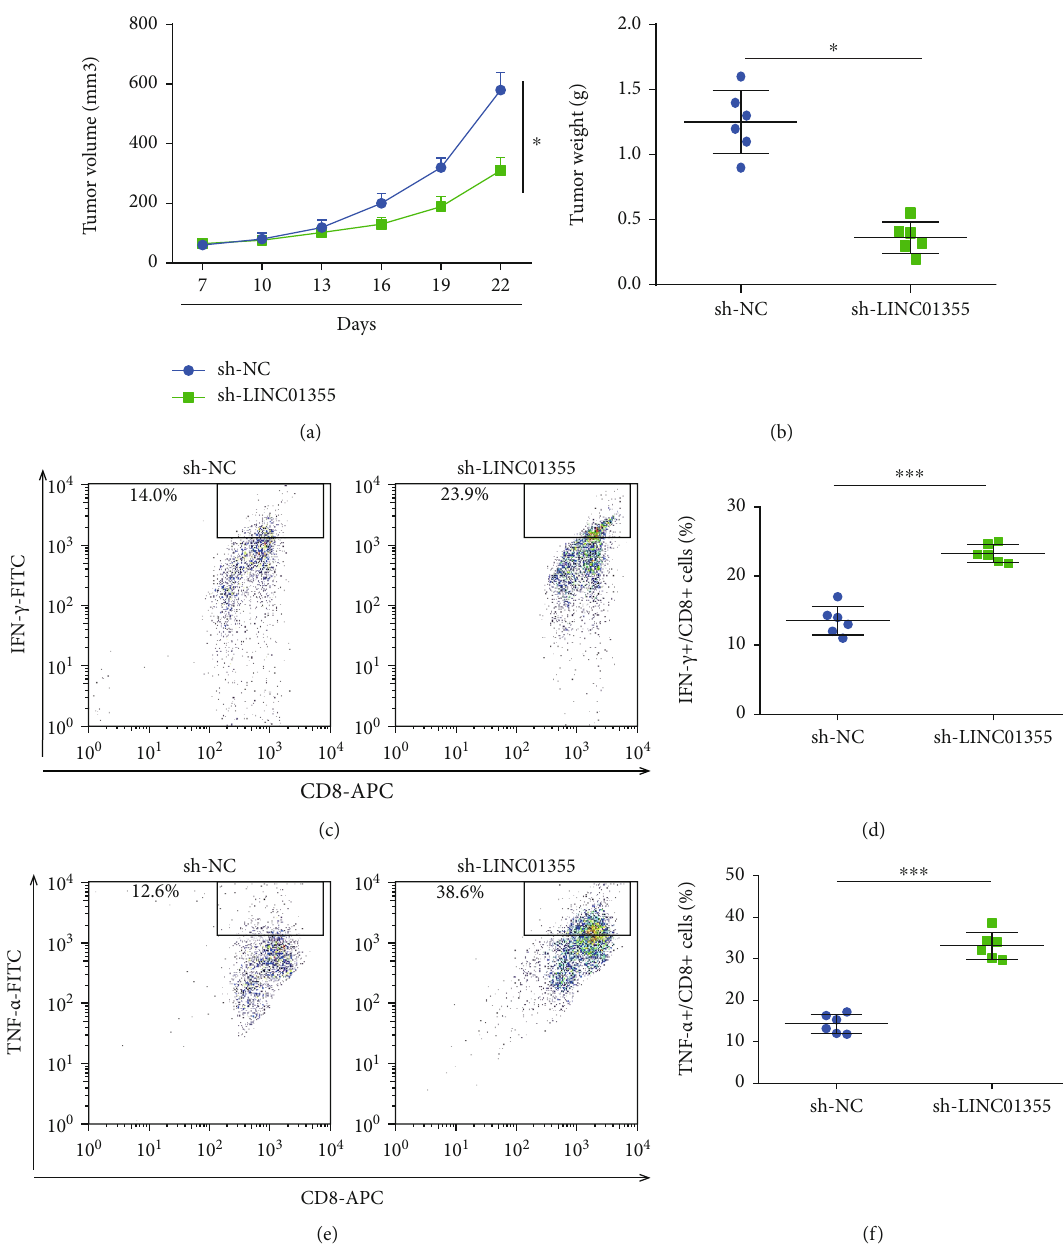
Figure 3: Knockdown of LINC01355 repressed tumor growth in vivo. BALB/c mice were challenged with 106 SCC-7 cells transfected with LINC01355 shRNA or NC subcutaneously. (a) Tumor volume. (b) Tumor weight was determined. (c, d) Frequency of tumor CD8+IFN- γ + cells was analyzed using fl ow cytometry. (e, f) Frequency of tumor CD8+TNF- α + cells was analyzed using fl ow cytometry. ∗ p < 0 : 05 ; ∗∗∗ p < 0 : 001